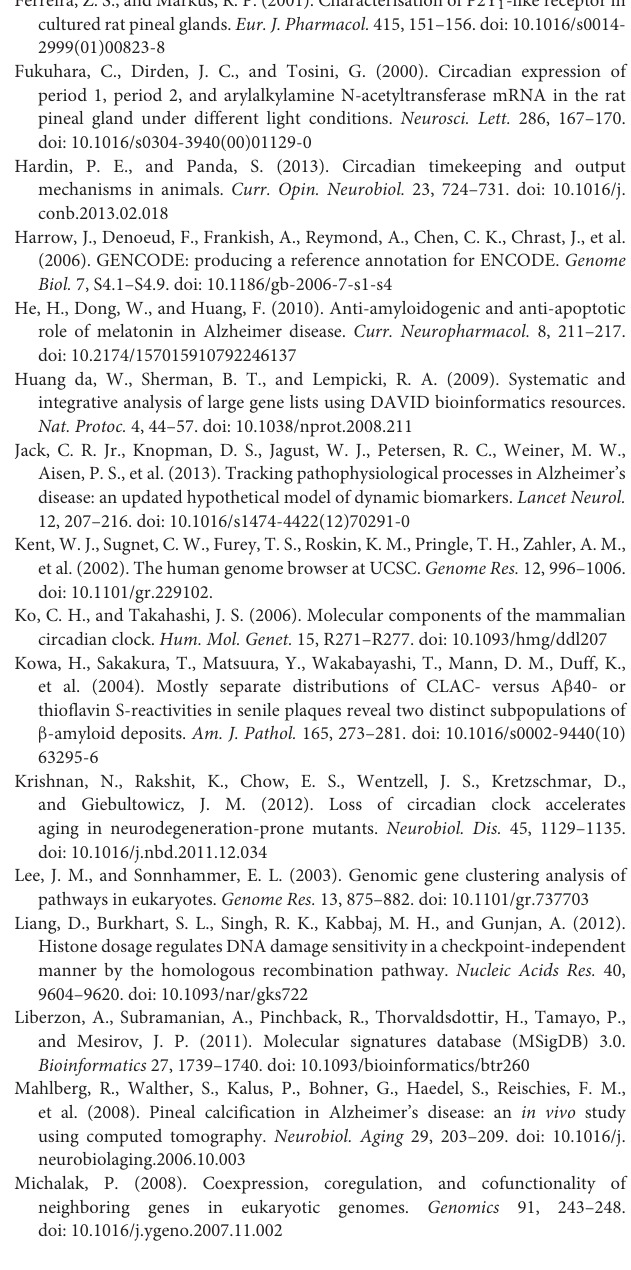
The expression change of the lncRNA RP23-479J7.2 in Figure 3E and five randomly selected circRNAs in Figure 4F were measured. P -values were calculated by a two-tailed t -test. (B) Confirmation of the circular structure of circRNAs by RNase R treatment. This data was used for the quantitation in Figure 4H . TABLE S1 | Expression of protein-coding mRNAs. TABLE S2 | Analysis of lncRNA expression. TABLE S3 | The read counts of circRNAs measured by STAR-DCC algorithm. TABLE S4 | Primers used in this